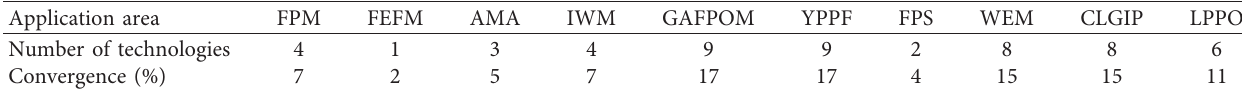
Table 8. The convergence of the disruptive technologies in these application areas is illustrated in Figure 8 and